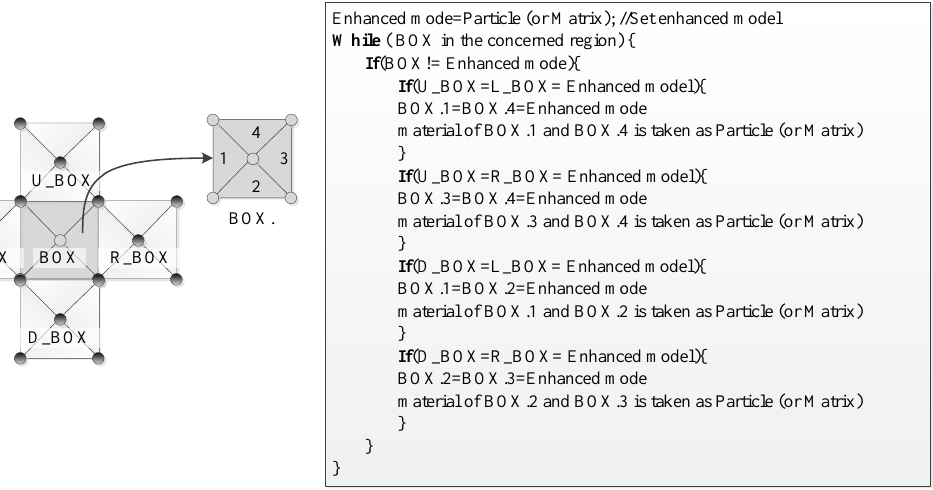
Figure 3. Two smoothing mode with the enhancement of particle or matrix.